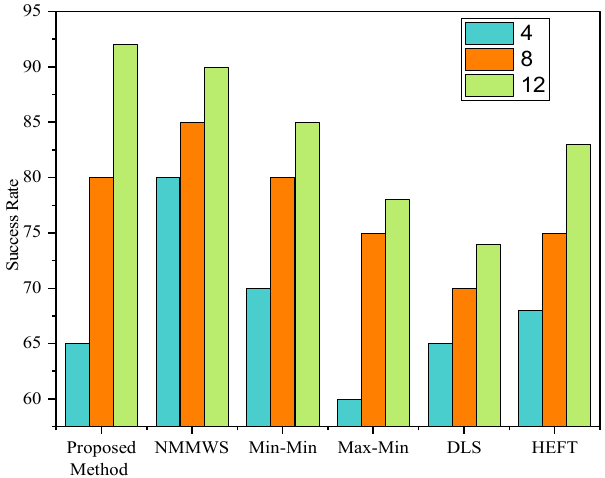
Figure 14. Success rate on the Montage workflow.